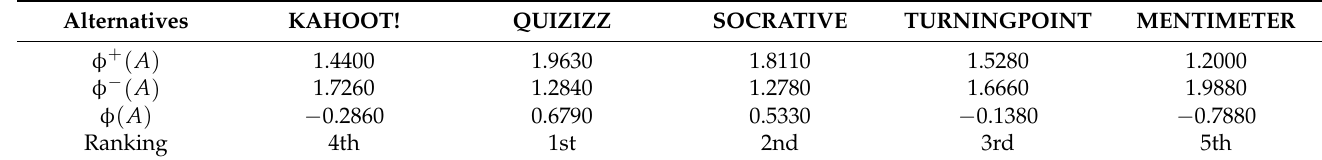
Table 12. Positive, negative, and net outranking flows in PROMETHEE